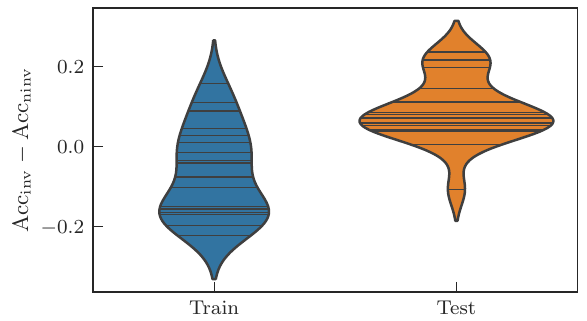
FIG. 7. Violin plot of the difference in achieved mean accu- racies between the invariant and noninvariant models in a sweep over different values of l and p as detailed in the text. Positive val- ues correspond to invariant models outperforming noninvariant ones. The mean is averaged over ten runs for each combination of l and p . We see that the mean accuracy on the training data is more or less the same for both invariant and noninvariant models, but that the invariant models clearly outperform the noninvariant ones on the test data. The magnitude of the difference compares well to the absolute test accuracies of both models that, depend- ing on l and p , lie between 0.17 and 0.97 (invariant) and 0.17 and 0.64 (noninvariant), significantly larger than the random guess- ing probability 0.17. The full training graphs are given in Fig. 15 in the